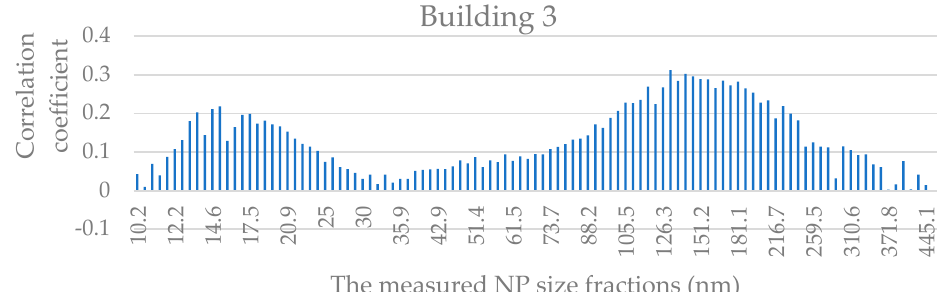
Figure 11. The correlation coefficients (Pearson) between the ventilation flow and the NP number concentration during the one-week measurement period presented for each size fraction in Building 3 during the heating season.